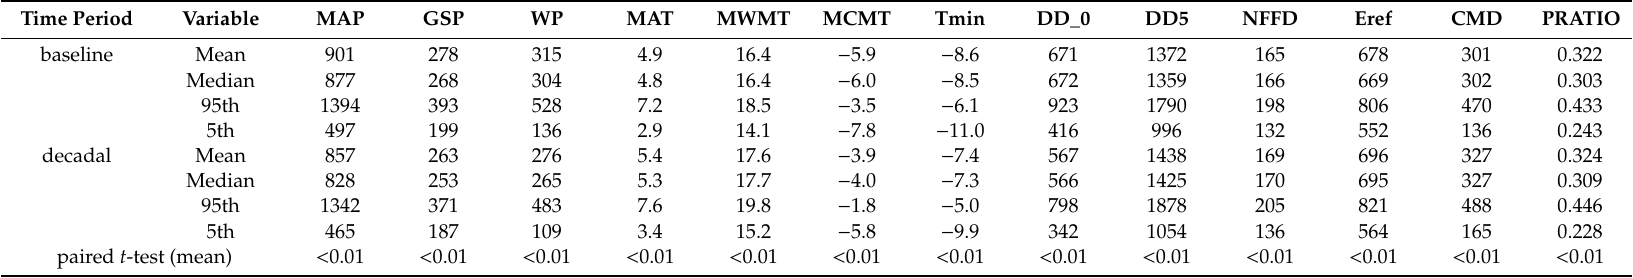
Table A1. Comparison of mean, median, and 95th and 5th percentile values of climate variables, including P-values of di ff erences in means ( α = 0.05) according to paired t -tests for baseline (1961–1990) versus recent decadal (2001–2010) time periods for 1286 plot locations. Variables are described in Table